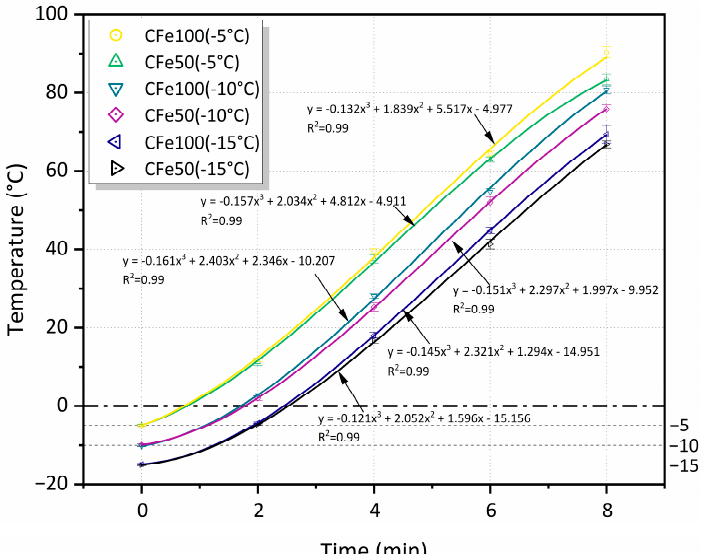
Figure 16. The surface temperature change of the specimens with microwave heating time under different initial ambient temperatures. Table 5. The heating rate within 0–2 min and the heating time to reach 0 °C.